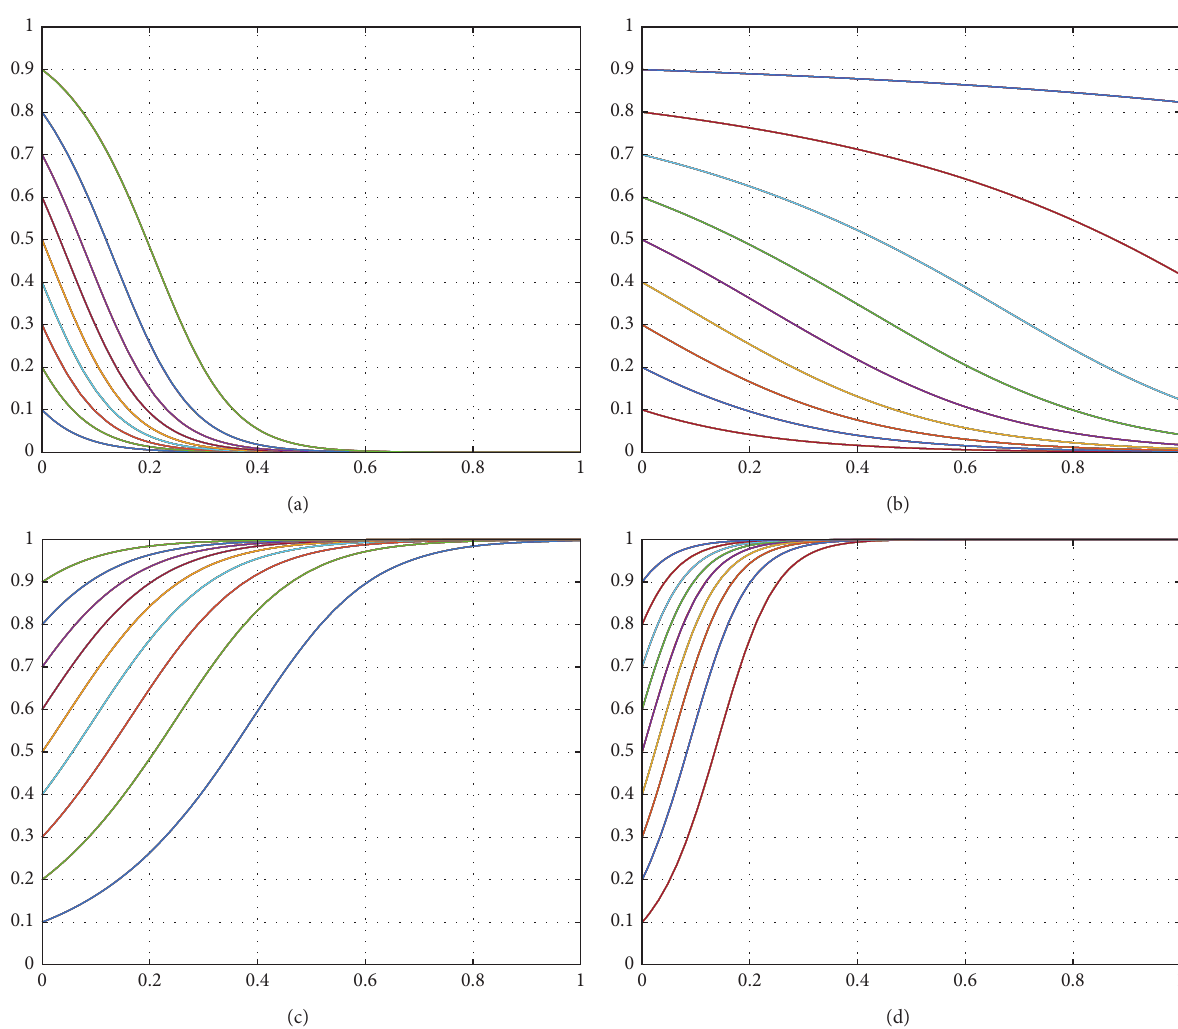
Figure 4: In the case of different β values, dynamic evolution process of information sharing: (a) β